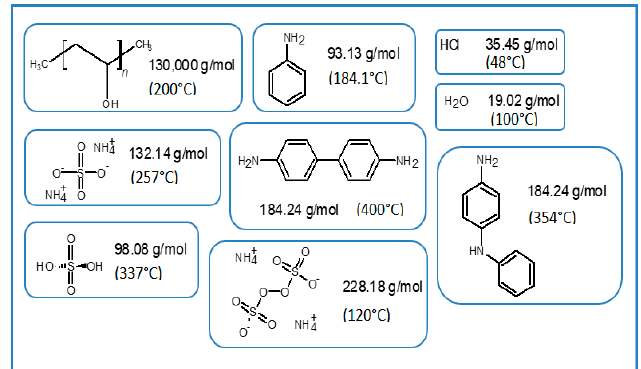
Figure 9. Molecular weight and transition temperatures of byproducts, sideproducts, and reagents present during synthesis.